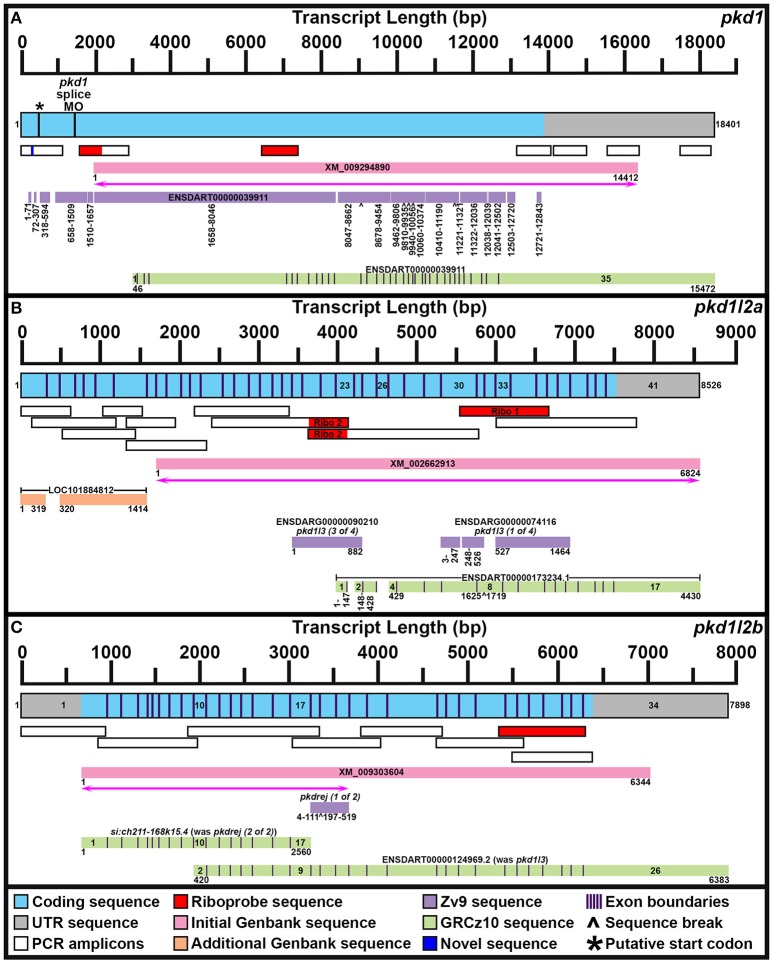
Mapping pkd1, pkd1l2a, and pkd1l2b mRNA Transcripts. Summary of mRNA transcript mapping results for pkd1
(A), pkd1l2a
(B), and pkd1l2b
(C). Approximate length in base pairs (bp) is indicated by scale at top of each panel. Mapped transcripts are shown in next row of each panel. Coding sequence is blue and UTR is gray. Numbers flanking these mapped transcripts indicate nucleotide positions. Black vertical lines (coding sequence box, A) indicate putative start codon, and morpholino sequence positions. Purple vertical lines (coding sequence boxes, A–C) indicate exon boundaries, where known. Mapped PCR amplicons generated in this study are indicated with white boxes. Red indicates riboprobe sequences used in this study. Dark blue indicates novel sequence identified in this study but not currently present in Ensembl GRCz10 genome. Genbank reference sequences used at beginning of this study are shown as pink boxes. Magenta lines with double arrows beneath these indicate regions of sequence homology identified at start of this project. Genbank reference sequences identified during this study are shown as orange boxes. Ensembl Zv9 transcript sequences are shown as lilac boxes. Ensembl GRCz10 transcript sequences are shown as green boxes. Numbers beneath sequences show nucleotide positions. ∧, break in aligned sequence. Thin purple vertical lines in green boxes indicate exon boundaries, where known. Key exons for interpreting mapping results are numbered. (A) Our newly mapped pkd1 transcript contains all but 173 bases of the older Zv9 ENSDART00000039911 transcript (lilac boxes) as well as all but the first 45 nucleotides of the current GRCz10 ENSDART00000039911 transcript (green boxes). We have also identified additional 5′ sequence and missing regions of coding sequence. The GRCz10 ENSDART00000039911 transcript corresponds to nucleotides 2975–18401 of our mapped transcript. The Zv9 ENSDART00000039911 transcript corresponds to nucleotides 218–13798 of our mapped transcript but contains some gaps (nucleotides 292–357, 430–597, 875–925, 1778–1786, 1935–1973, 8363–8410, 9804–9811, 10715–10725, 11608–11640, 12356, 12359–12389, 12852–12890, and 13109–13675 of our mapped transcript). Inverse PCR identified 5′ transcript sequence along with a novel stretch of nucleotides (292–357) absent from GRCz10 Ensembl genome (shown in dark blue). Nucleotides 2659–12720 of the Zv9 transcript are almost 100% identical to nucleotides 46–10179 of the GRCz10 transcript and these regions align with nucleotides 2975–13108 of our mapped transcript. Nucleotides 10180–10746 of the GRCz10 transcript share no homology with the Zv9 transcript, but correspond to nucleotides 13109–13675 of our mapped transcript. Nucleotides 12721–12843 of the Zv9 transcript share 100% homology with nucleotides 10747–10869 of the GRCz10 transcript and correspond to nucleotides 13676–13798 of our mapped transcript. The coding sequence of the GRCz10 transcript terminates 30 nucleotides downstream of the Zv9 transcript and is followed by 4573 bp of unique 3′ UTR sequence. Using RT-PCR we have confirmed that our mapped transcript utilizes the same stop codon and 3′ UTR sequence. Specifically, we have confirmed that nucleotides 10192–11136, 11173–12085, 12598–13484, and 14524–15376 of 3′ UTR sequence in the GRCz10 transcript are transcribed and map to nucleotides 13121–14065, 14102–15014, 15527–16413, and 17453–18395 of our mapped transcript, respectively. Our inverse PCR revealed 217 nucleotides of coding sequence upstream of the Zv9 transcript and 66 nucleotides of novel coding sequence between nucleotides 71 and 72 of the Zv9 transcript. In total, this produces a 18401 bp transcript that encodes a 4608 amino acid protein and we have deposited this sequence in NCBI (NCBI accession number KY074550). This sequence lacks a start methionine. *indicates in-frame methionine at 527–529 nucleotides. However, if this is the start codon, the resulting protein would lack the leucine rich repeat domain, encoded by the 175 amino acids in-frame upstream of this methionine, that is present in mouse, human and stickleback PKD1. There is a putative in-frame start codon a further 54 nucleotides (18 amino acids) upstream of our present transcript, which we think is more likely to be the true start codon. The location of the splice-blocking morpholino sequence used by Mangos et al. (2010) that resulted in kidney cysts in some animals is also indicated (nucleotides 1187–1197 of the Zv9 transcript). (B) Our current transcript for pkd1l2a encompasses both LOC101884812 and XM_002662913 and contains additional exons not present in either of these sequences. The start of the current ENSDART00000173234.1 transcript coincides with the start of exon 23 in our longer transcript, but the first exon of ENSDART00000173234.1 is shorter than exon 23 in our transcript. Exons 2–3, 4–7, and 9–17 of ENSDART00000173234.1 are identical to exons 24–25, 27–30, and 33–41 of our transcript. Exon 26 of our transcript is absent in ENSDART00000173234.1 and exons 31–32 and intron 31–32 exist as a single exon, exon 8, in ENSDART00000173234.1. (C) Our current transcript for pkd1l2b contains both the si:ch211-168k15.4 and ENSDARG00000101214 (ENSDART00000124969.2) sequences, utilizing a start codon 4 bases upstream of exon 1 in the current si:ch211-168k15.4 annotation, and transitioning between exon 16 of si:ch211-168k15.4 immediately into exon 9 of ENSDART00000124969.2. Nucleotides 683–7026 of our new 7898 bp mRNA transcript align perfectly with the original XM_009303604 6344 bp reference sequence. The start codon was identified in this study along with novel 5′ UTR sequence.